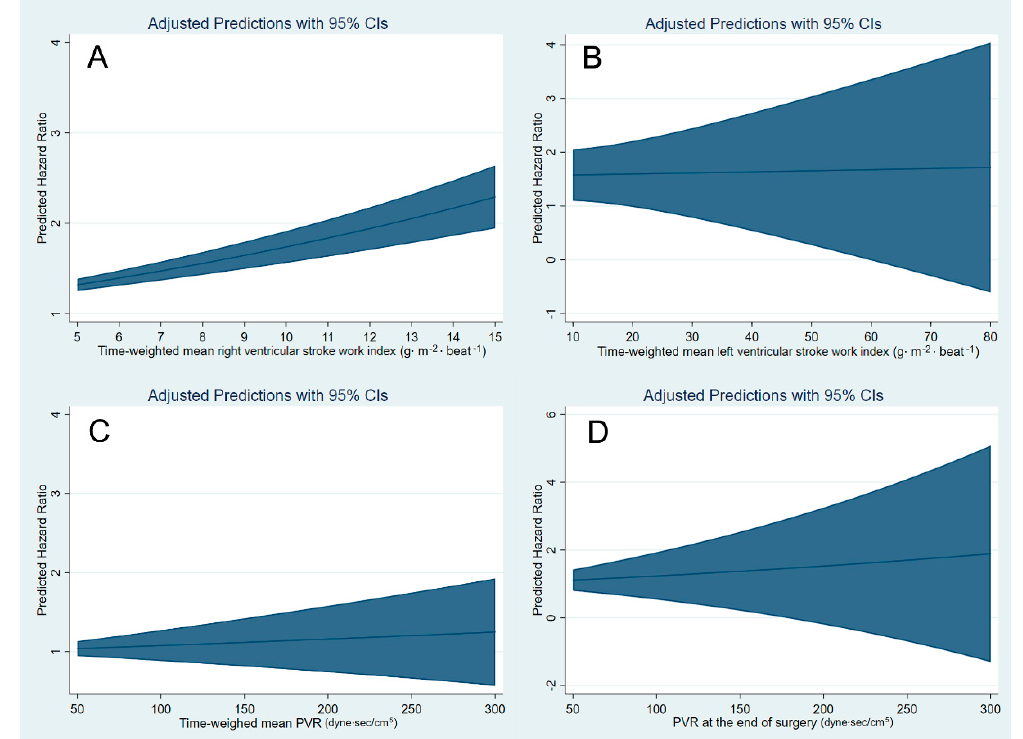
Figure 3. Cubic spline function curves of multivariable-adjusted relationship between intraoperative time-weighted mean right ventricular stroke work index ( A ), time-weighted mean left ventricular stroke work index ( B ) and time-weighted mean pulmonary vascular resistance (PVR) ( C ) and PVR at the end of surgery ( D ) as continuous variables and the risk of one-year all-cause mortality or graft failure.